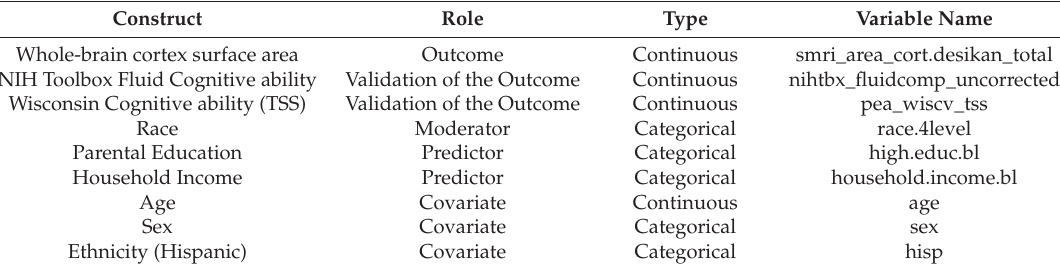
Table A1. Variable in this study.